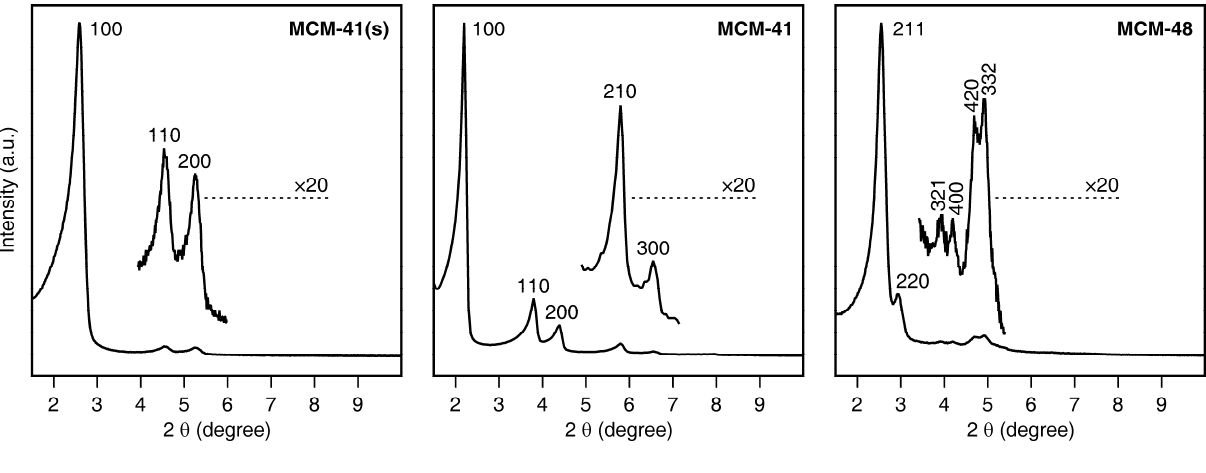
Figure 2. X-ray diffraction patterns of parent MCM-41(s) (left panel), MCM-41(middle panel), and MCM-48(right